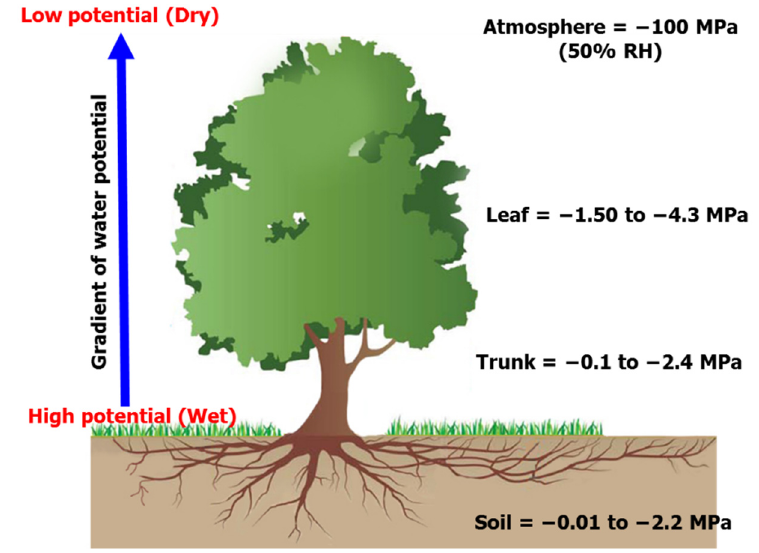
Figure 7. An example of soil-plant-atmosphere